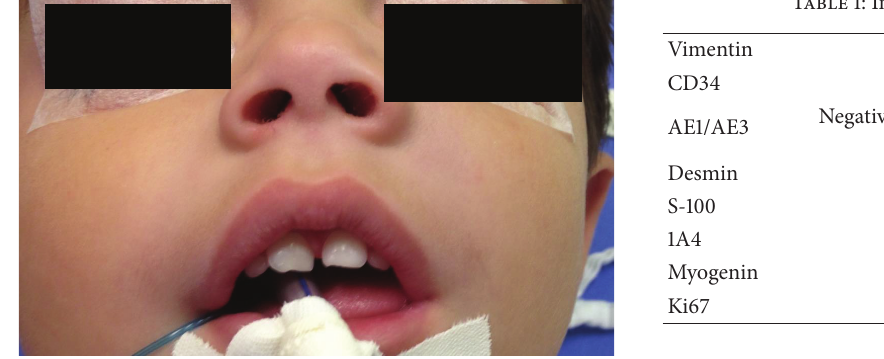
Table 1: Immunohistochemical